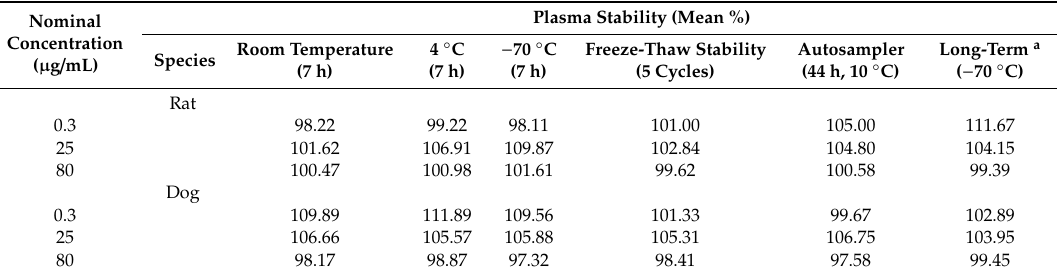
Table 3. Stability data for THAP in rat and dog plasma samples ( n =